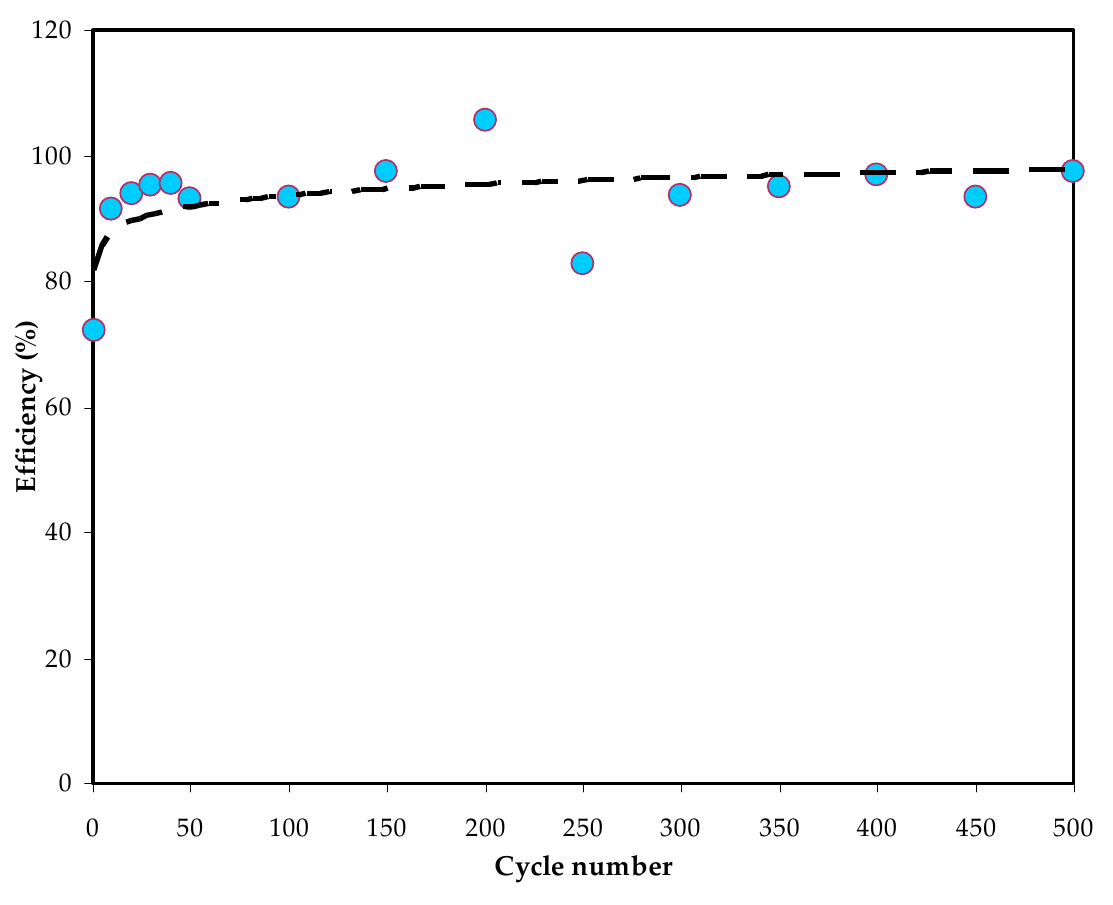
Figure 18. Efficiency prototype of the EDLC device over 500 cycles. Evaluation of the EDLC assembly via calculating the efficiency of the system can be achieved from both E and p using the followingequations: